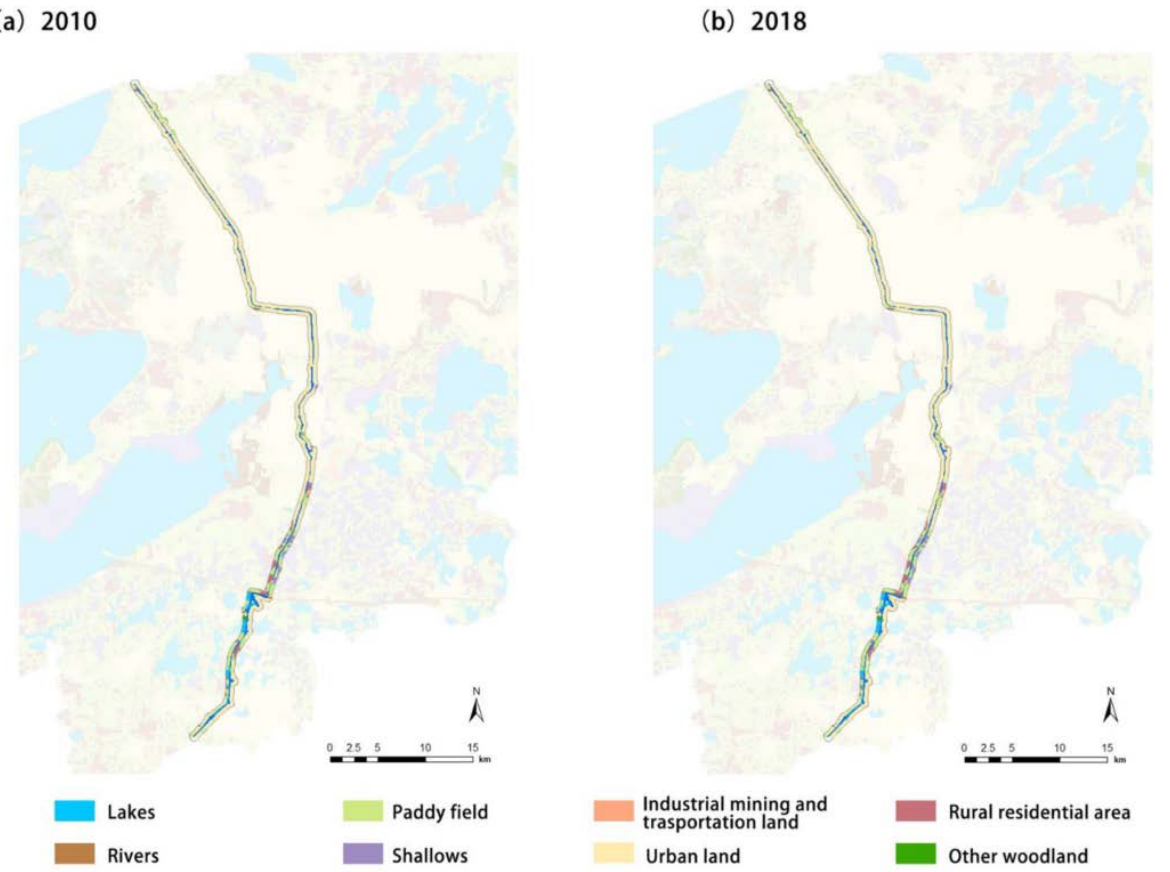
Figure 4. Grand Canal land use status in in 2010 and 2018 (eight land use types with urban land the main type of land